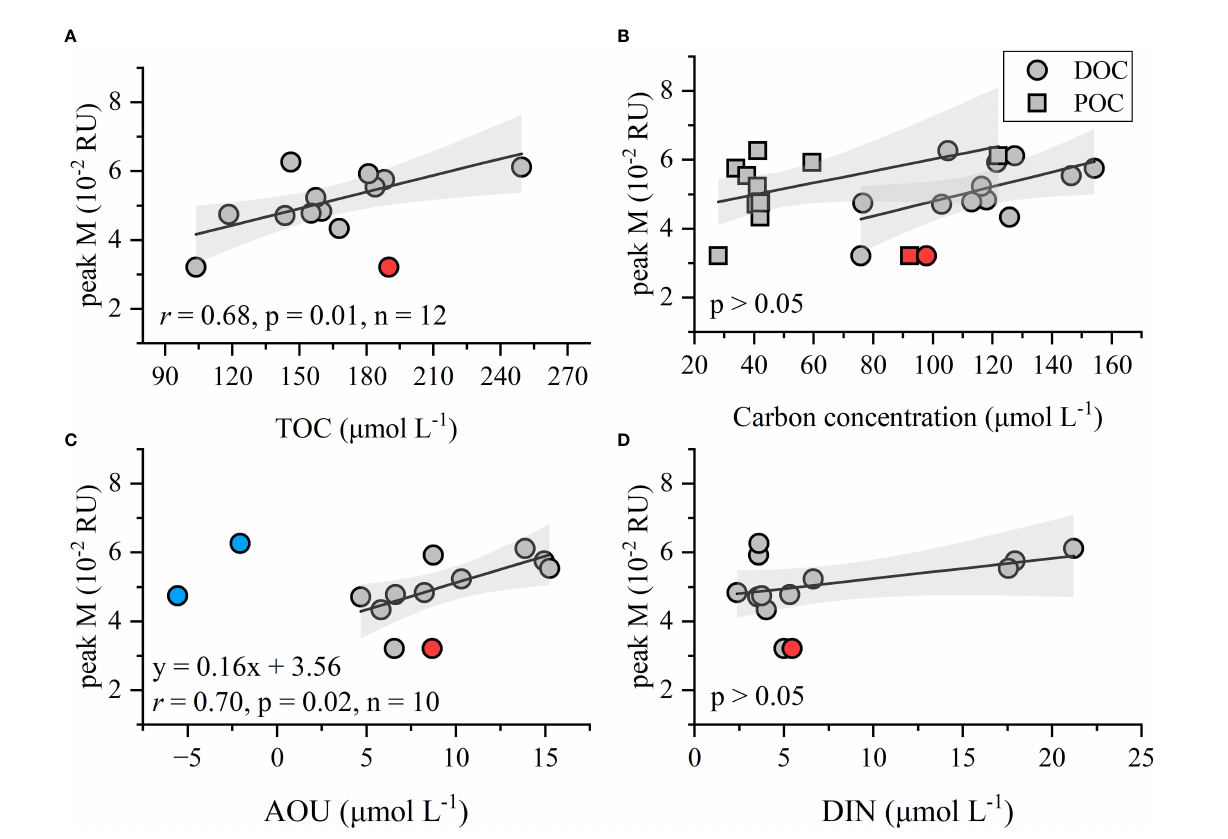
FIGURE 8 Relationships between the intensity of humic-like peak M versus TOC, DOC, POC, AOU, and DIN. The red point is an abnormal value (outlier) that was excluded from linear fi tting. Blue points are the negative AOU values also excluded from linear fi tting. Gray shading shows the 95% con fi dence bands for the fi tted regression lines. (A) Relationships between peak M and TOC; (B) Relationships between peak M and DOC; (C) Relationships between peak M and AOU; (D) Relationships between peak M and